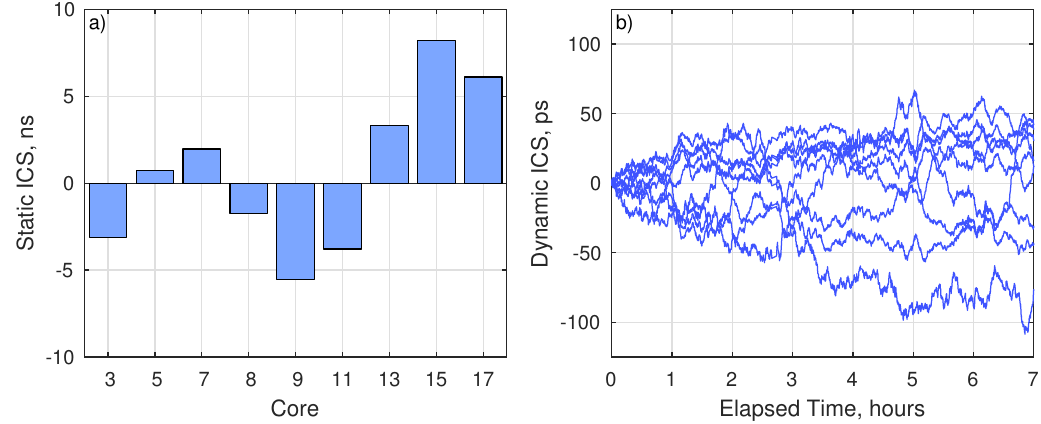
Figure 5. Inter-core skew (ICS) of the 30 km MCF link for the pSSC. ( a ) Static ICS and ( b ) dynamic ICS over a period of 7